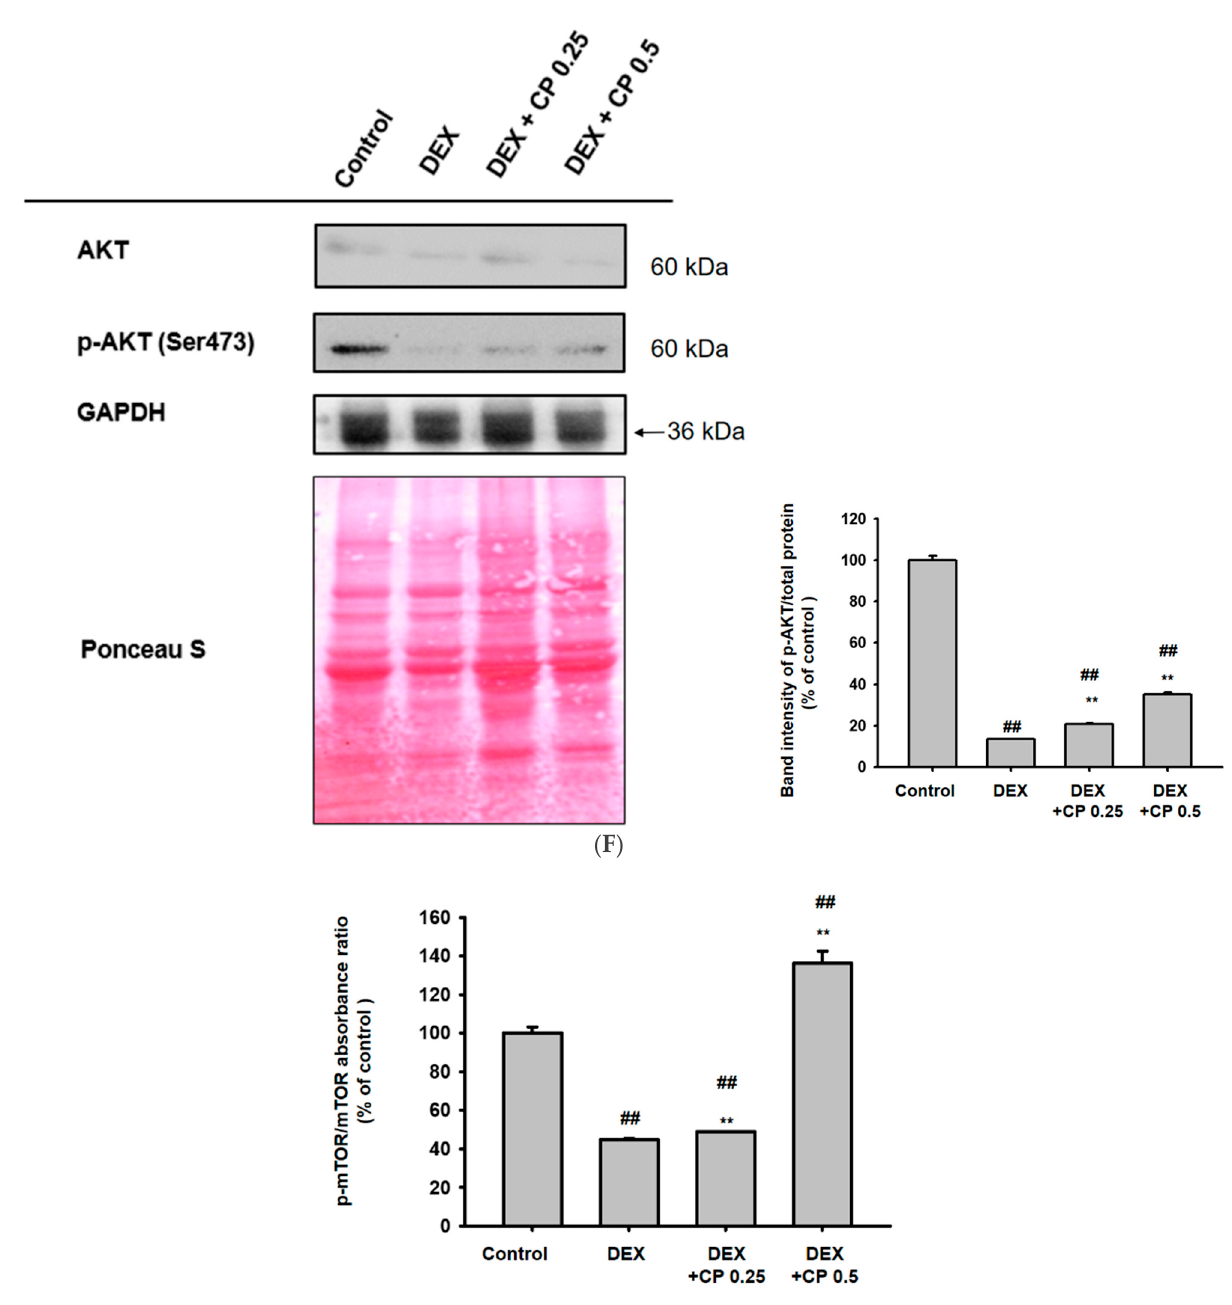
Figure 3. Effect of CP on myokine alterations. ( A – D ) The mRNA expression of myostatin ( A ), TGF- β ( B ), BDNF ( C ), and FNDC5 ( D ) in the muscles was assessed using real-time PCR. ( E , F ) Total Smad2/3, phospho-Smad2, total-AKT, phospho-AKT, and GAPDH levels in the muscles were assessed by immunoblotting. Total proteins were stained by Ponceau S. ImageJ was used to measure and quantify the band intensity. Arrow in ( E ) indicates p-Smad 2, and this band was used to quantify the p-Smad2 level. The p-Smad2 and p-AKT levels were normalized by Ponceau S staining. ( G ) Total and phospho-mTOR levels were analyzed by ELISA. The p-mTOR levels were normalized against the total mTOR levels. Data are presented as the means ± SD of values obtained from seven biological replicates. # p < 0.05, ## p < 0.01, DEX vs. control. # p < 0.05, ## p < 0.01, DEX + CP (0.25 and 0.5) vs. control. * p < 0.05, ** p < 0.01, DEX + CP (0.25 and 0.5) vs. DEX; CP, collagen peptides; DEX, dexamethasone.